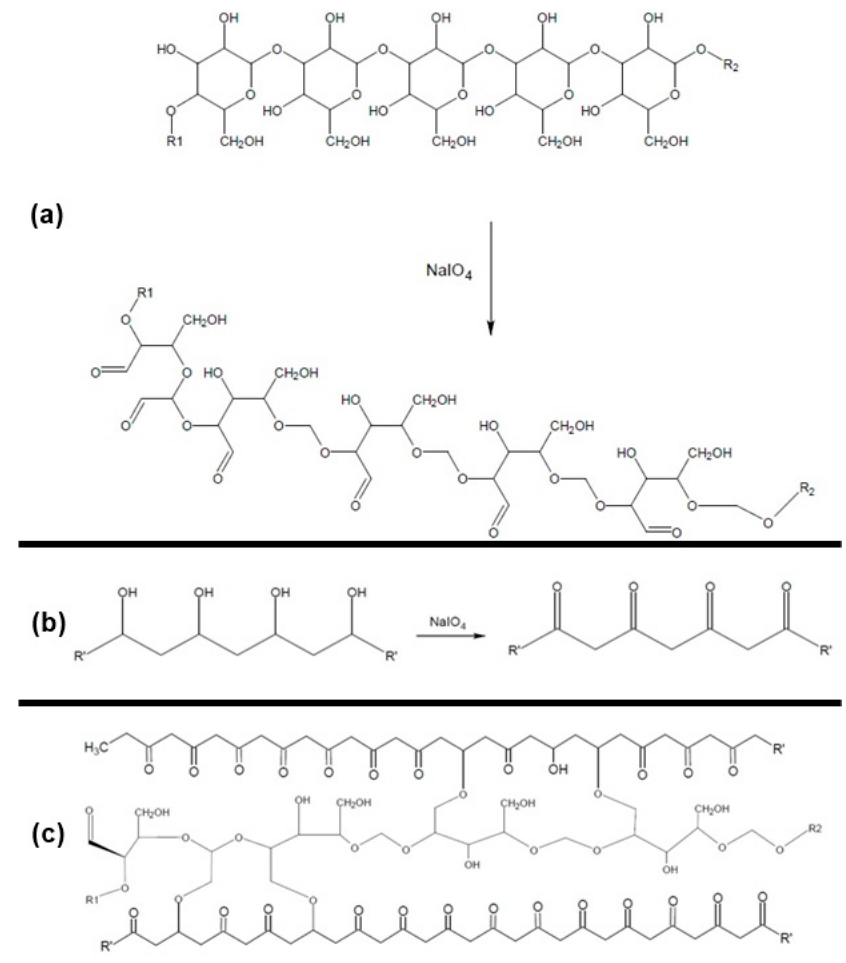
Figure 2. Scheme of ( a ) oxidative effect of oxidant agent (NaIO 4 ) on the cashew gum polysaccharide (CGP) structure; ( b ) oxidative effect of NaIO 4 on the polyvinyl alcohol (PVA) structure; and ( c ) chemical structure of the CGP/PVA films.